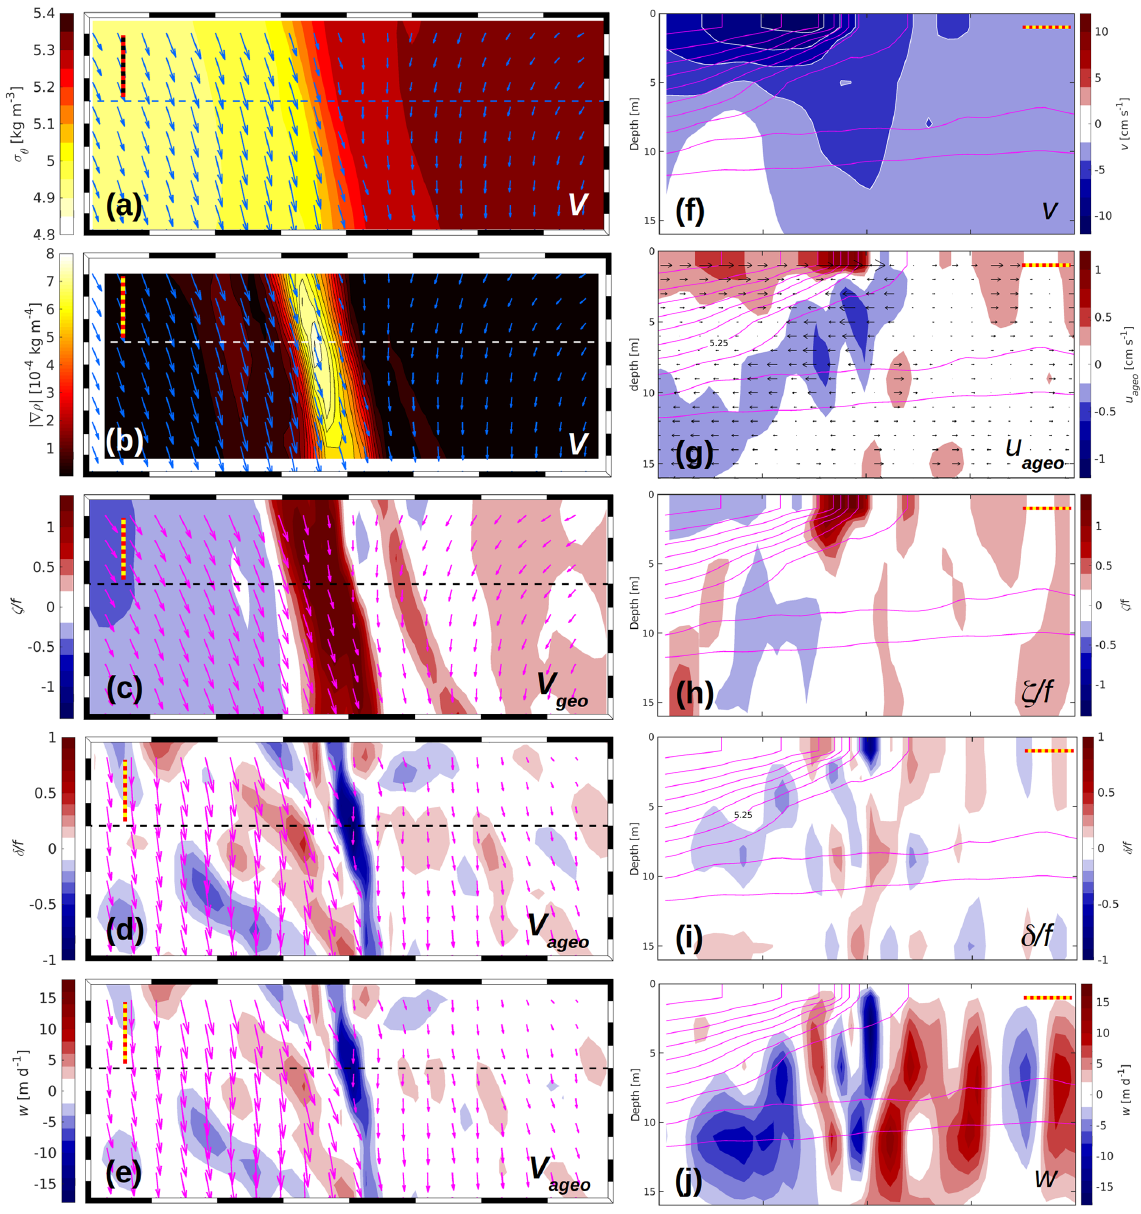
Figure 16. R100, 26 June: maps of dynamical quantities within the black box in Fig. 15; (a) σ θ and V , (b) |∇ ρ | and V , (c) ζ/f and V geo , and (d) δ/f and V ageo in the top layer, as well as (e) w and V ageo at the bottom of the top layer. Velocity vectors are drawn at a resolution of 200m. Vertical sections of (f) v , (g) u ageo , (h) ζ/f , (i) δ/f , and (j) w . Contour lines of potential density anomaly σ θ are magenta and spaced at the same intervals as in (a) . The horizontal dashed lines in the centres of (a) – (e) indicate the position of the zonal sections displayed in (f) – (j) . In either subplot, the dashed rulers represent a horizontal distance of 500m.